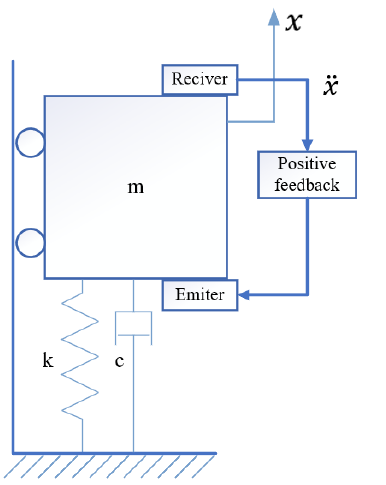
Figure 4. A 1-DOF equivalent model for the SAS